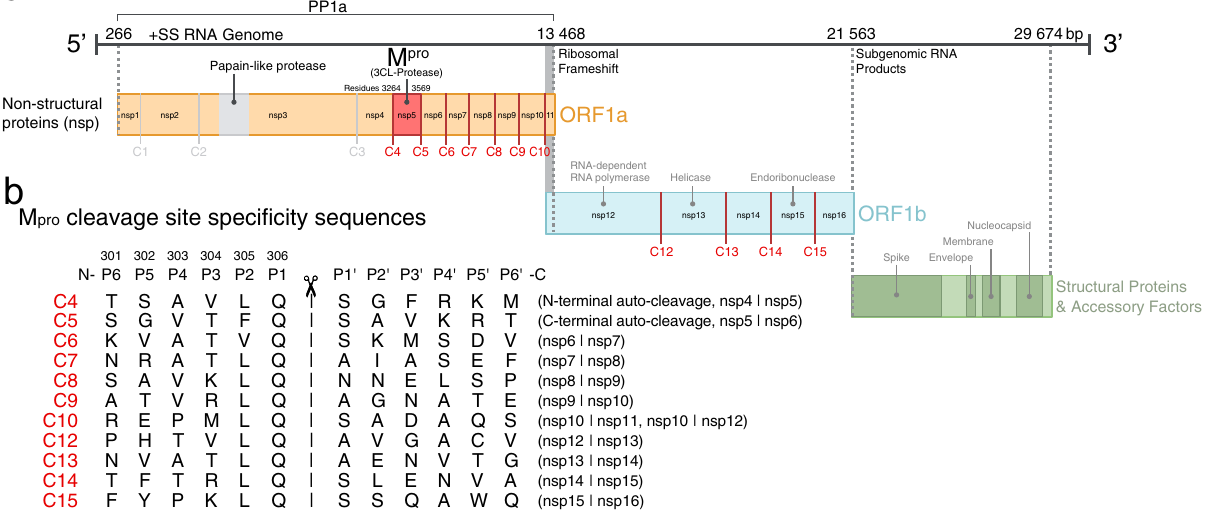
speci fi city residues (P6 – P6 ′ ). Amino acid numbering above P6 – P1 is as for C5, the C-terminal autocleavage sequence of M pro itself, the template into which all other cleavage site P6 – P1 sequences were systematically substituted in this